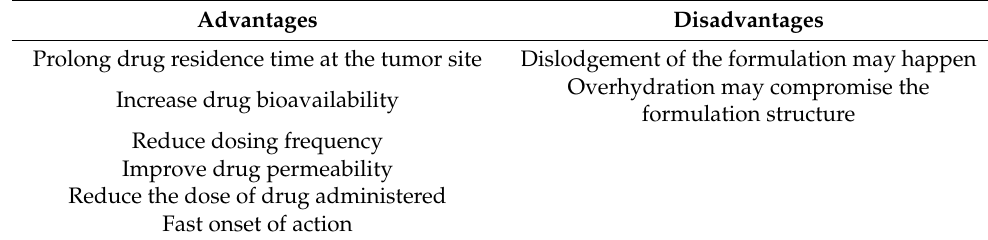
Table 2. Mucoadhesive DDS: advantages and disadvantages